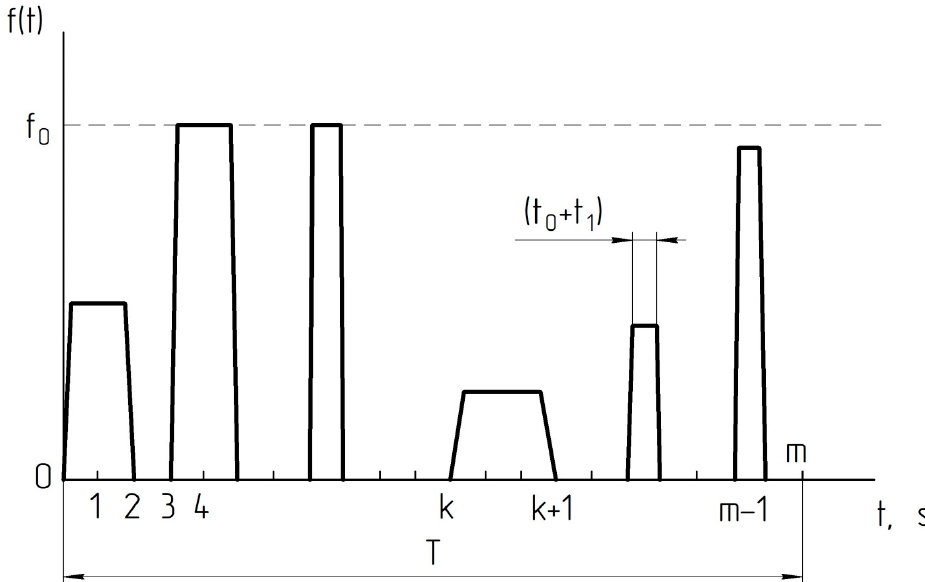
Figure 2. Quasi-trapezoidal modulation function of the rotor system.